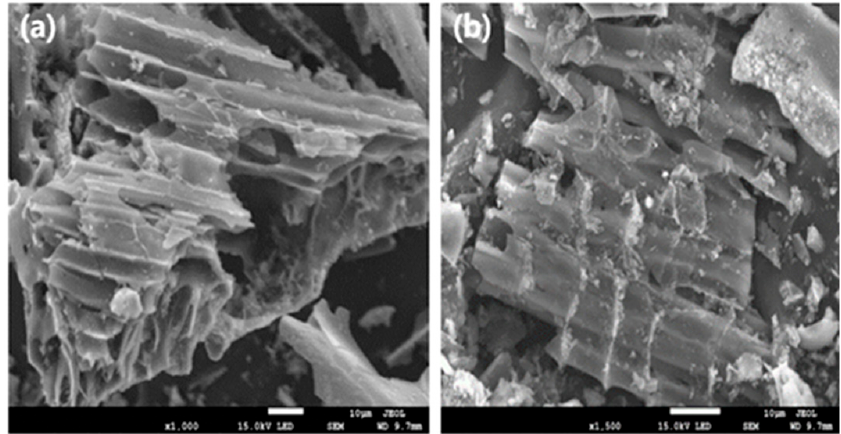
Figure 8. ( a )Scanning electron microscope images of biochar and ( b ) modified biochar. Figure 8. ( a ) Scanning electron microscope images of biochar and ( b ) modified